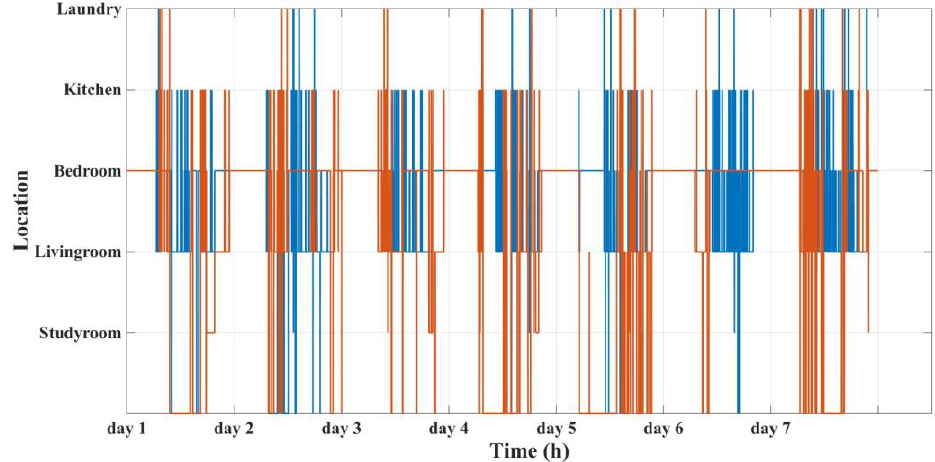
Figure 11. Residents’ localization results for the whole week.